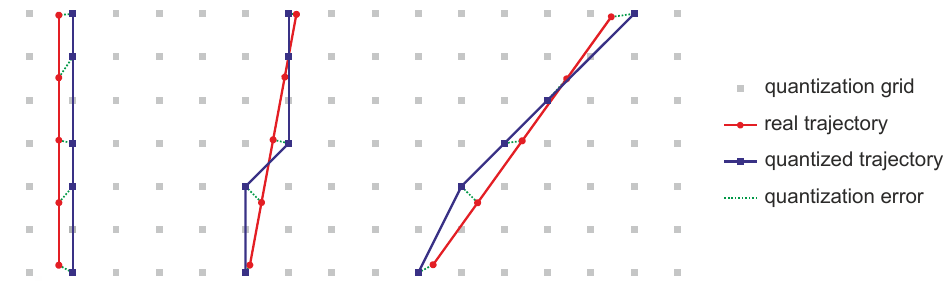
Figure 2. RMC Sentences acquired from two different GPS receivers. The yellow-highlighted numbers represent the latitude and longitude geodetic coordinates. It can be observed that the high end Trimble R4 provides 12 digits for latitude and 13 for longitude while the low-cost Navilock NL-402U provides only eight digits for latitude and nine for longitude. RMC sentence obtained from a Trimble R4 GPS receiver: $GPRMC,133130.00,A,4118.88923333,N,00450.90354850,W,0.034,89.860,230912,1.9091,W,A*35 RMC sentence obatined from a Navilock NL-402U GPS receiver: